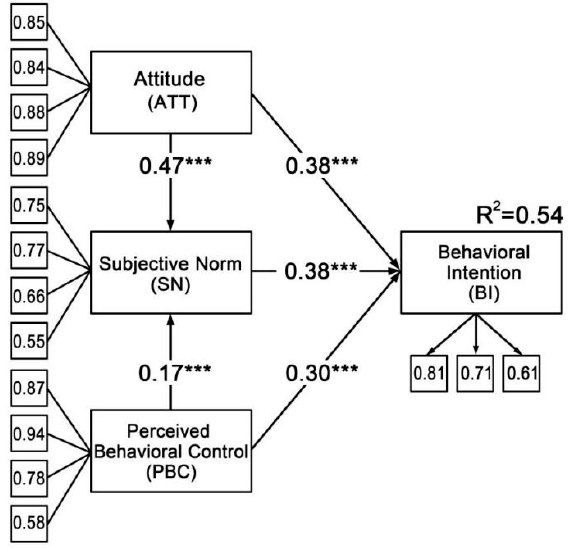
Figure 2. Possible causal relationships between the attitude, subjective norm, perceived behavioral control, and behavioral intention; *** p < 0.001. Table 6. Goodness-of-fit measures (GOFs) for the structural equation